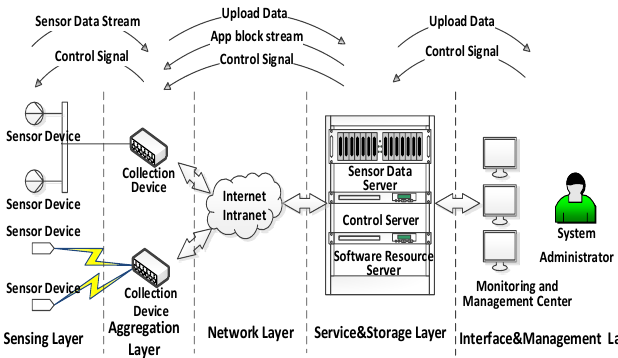
Figure 3. The architecture of industrial IoT based on